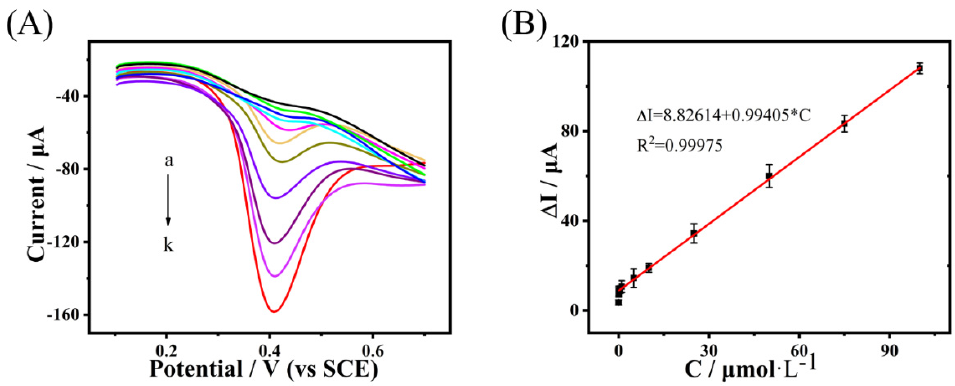
Figure 6. ( A ) DPV curves recorded for the Cu-H-T@rGO/GCE electrode under the different (0.01, 0.05, 0.1, 0.5, 1, 5, 10, 25, 50, 75, and 100 µ mol · L − 1 , marked as a → k) BPA solutions in 0.2 mol · L − 1 PBS 0.05, 0.1, 0.5, 1, 5, 10, 25, 50, 75, and 100 μ mol·L − 1 , marked as a → k) BPA solutions in 0.2 mol·L − 1 PBS (with pH = 7.0); ( B ) oxidation peak current plotted as a function of the BPA concentration.